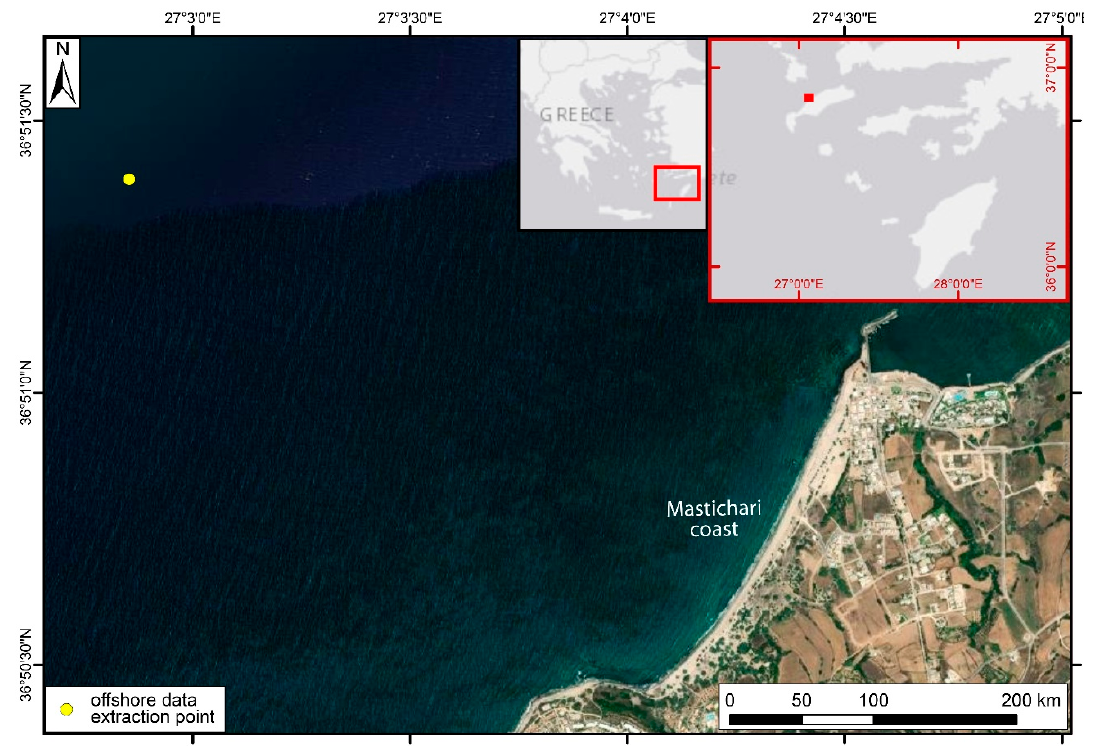
Figure 1. The study area of the coast of Mastichari and the offshore wind and wave data extraction point in Kos island, Greece.